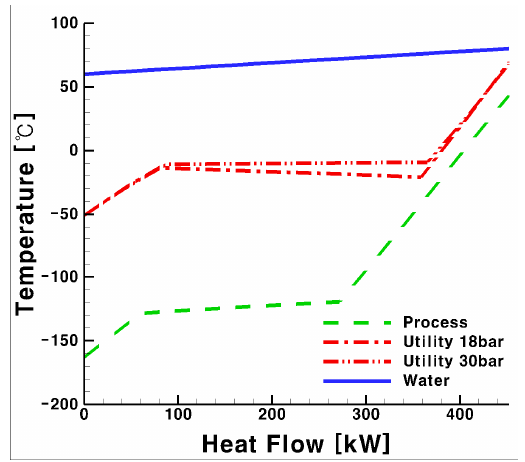
Figure 9. Heat transfer performance as a function of pressure in each group when using CO 2 as a heat medium.